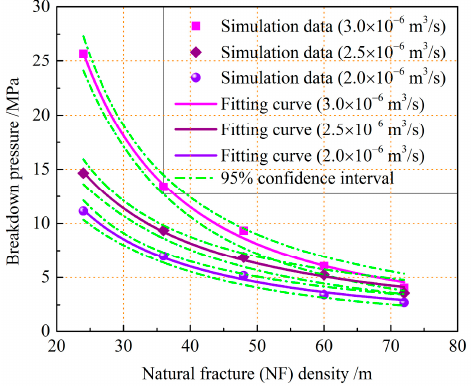
Figure 26. Variation of breakdown pressure with NF density under different injection rates and confining pressure ratio is S H : S h = 10:5. Table 7. Fitting curve equations of breakdown pressure under different injection rates